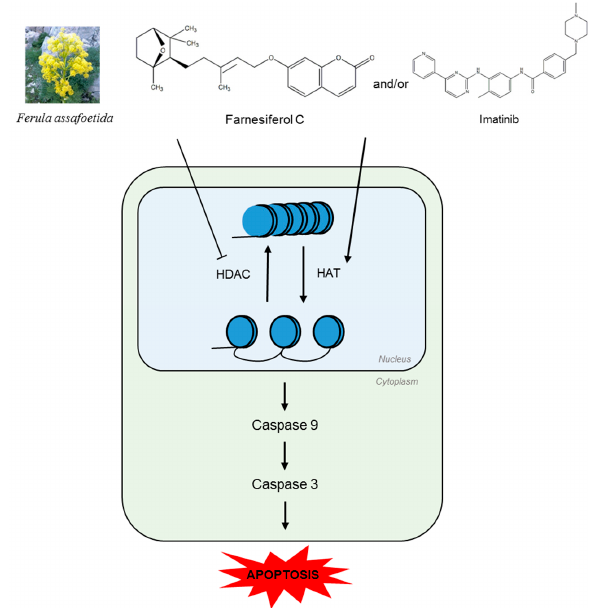
Figure 7 . Graphical abstract on the apoptotic mechanism of FC in chronic myelogenous leukemia cells as an Imatinib sensitizer via caspase 3 activation and HDAC inactivation. Blue circle indicates histone protein.